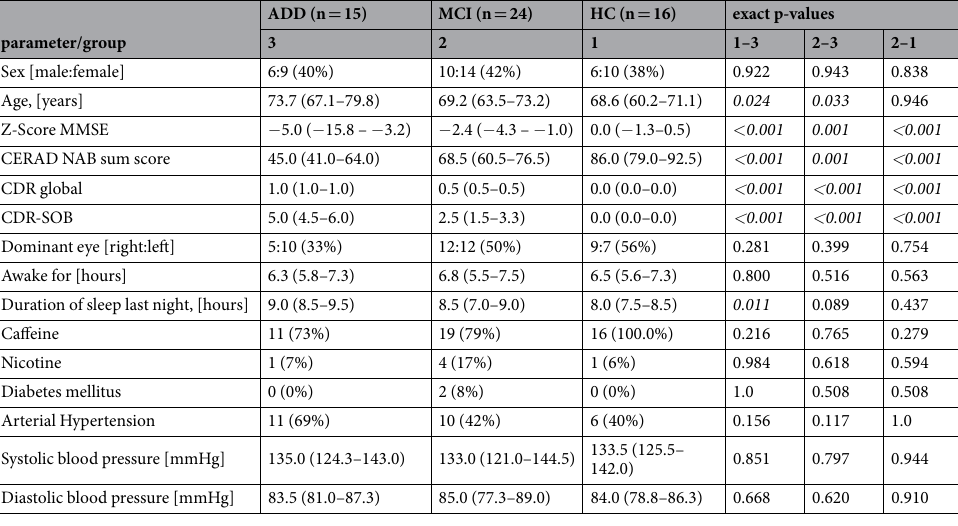
Table 2. Values of biometric and systemic parameters in the cohort. Legend to Table 2: Absolute (relative) frequency or median (1 st quartile – 3 rd quartile) where appropriate. Significance for categorical ( χ 2 - test) and continuous variables (Mann-Whitney-U-test). Exact p-values reported without correction for multiple comparisons. P-values < 0.05 are accentuated with italic. ADD: Alzheimer’s disease dementia, HC: cognitively healthy controls. MCI: mild cognitive impairment. MMSE: Mini-Mental state examination; CERAD NAB: Consortium to Establish a Registry for Alzheimer’s Disease Neuropsychological Assessment Battery; CDR-SOB: Clinical dementia rating sum of